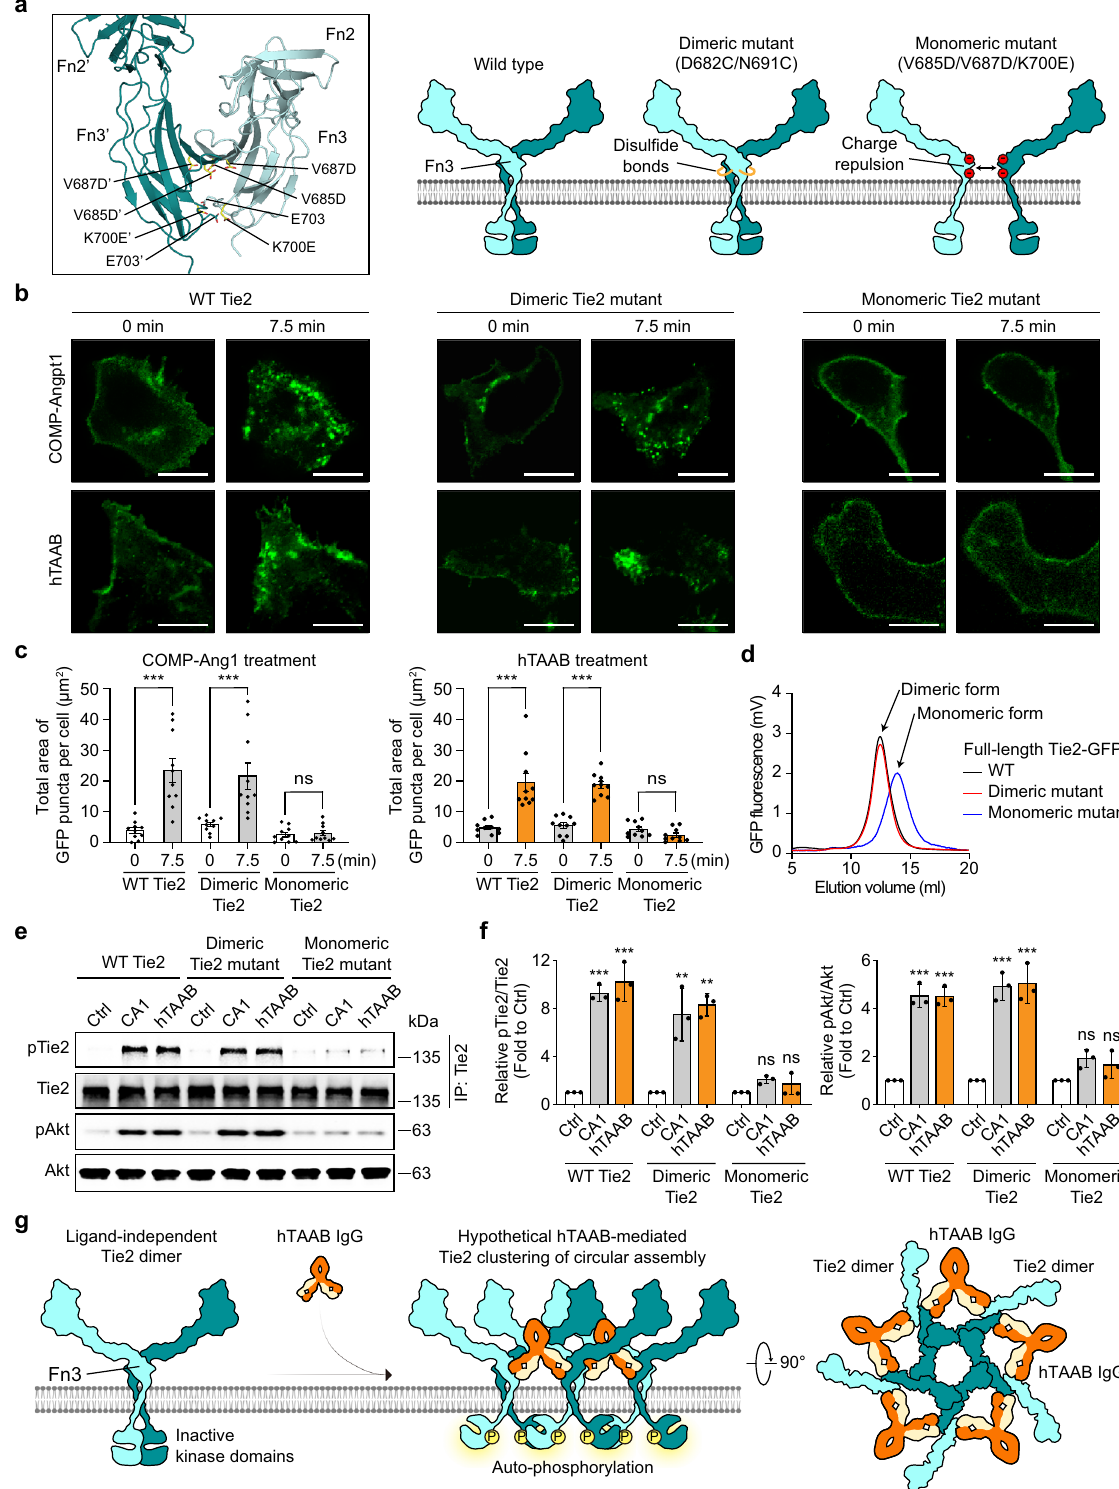
containing the constant region of human Ig γ 1 heavy chain (GenBank accession number: AWK57454.1) and a pcDNA3.3- TOPO vector containing the constant region of human Ig κ light chain (GenBank accession number: AAA58989.1), respectively. After co-expressing hzTAAB-H1 and hzTAAB-L1 in HEK293F cells and purifying the antibodies to homogeneity as full-length IgG1 by protein A af fi nity chromatography and SEC (Supplementary NATURE COMMUNICATIONS| (2021) 12:6287